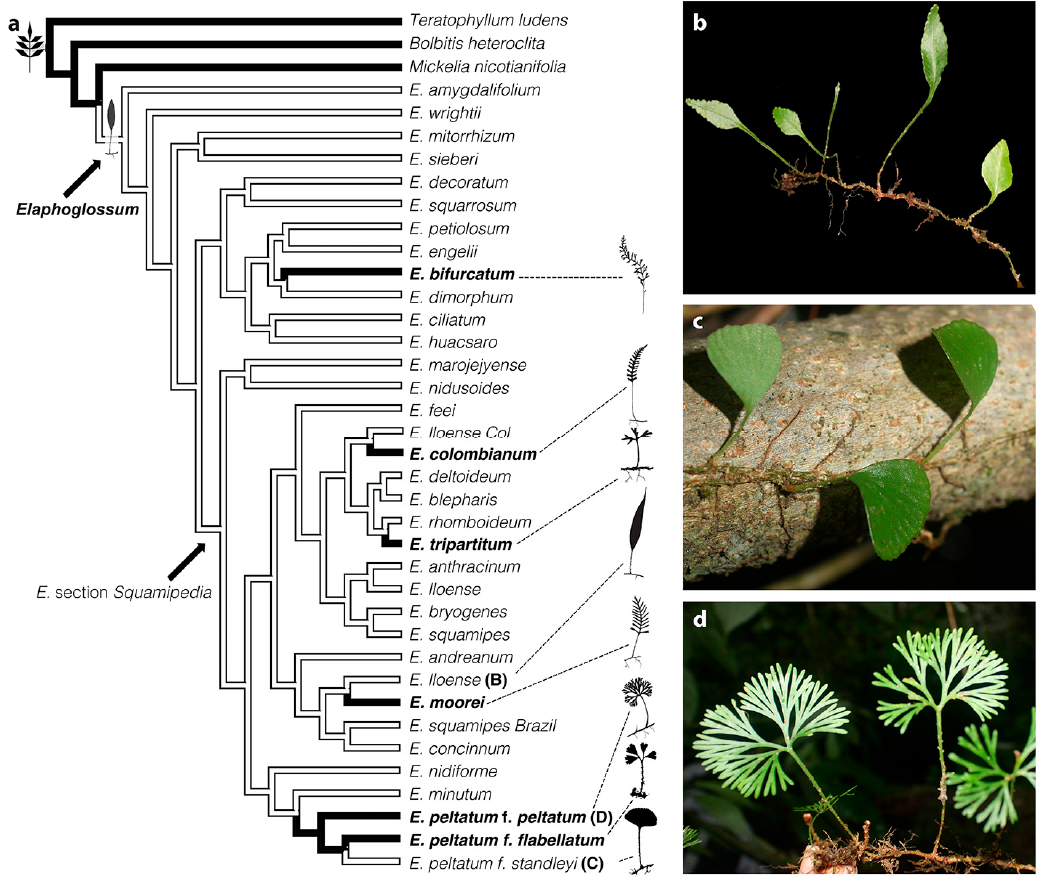
Figure 1. Leaf morphological variation in the genus Elaphoglossum. ( a ) Phylogeny of Elaphoglossum with leaf dissection optimized onto the tree (characters were optimized under a parsimony criterium with Mesquite V. 3.5). Black branches = divided leaves, white branches = simple leaves (modified from [36]). Divided-leaf taxa are in bold and displayed as shadow diagrams (not to scale), and the letter after species indicates species included in the expression studies. (b–d) The three closely related taxa studied of Elaphoglossum section Squamipedia . ( b ) Elaphoglossum lloense (simple leaves). ( c ) Elaphoglossum peltatum f. standleyi (simple leaves). ( d ) Elaphoglossum peltatum f. peltatum (divided leaves).